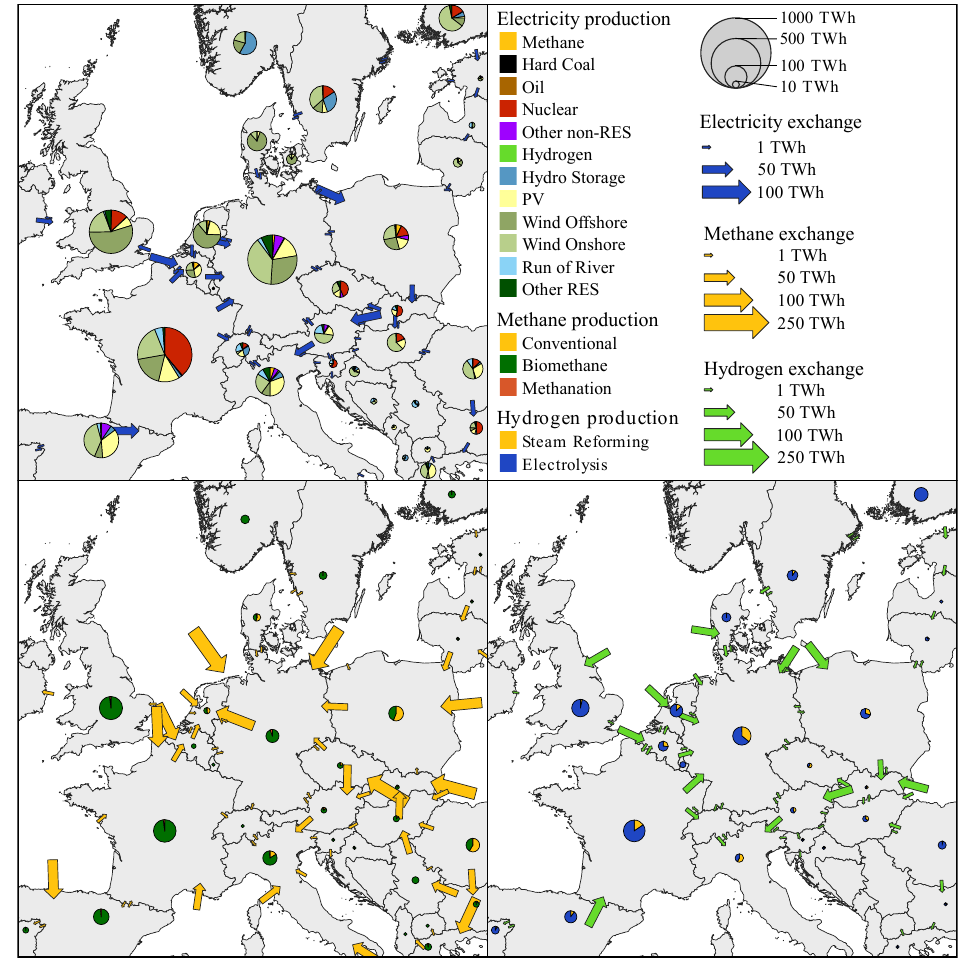
Figure 5. European production and exchange of electricity ( top ), methane ( bottom left ) and hydrogen ( bottom right ), (model result).